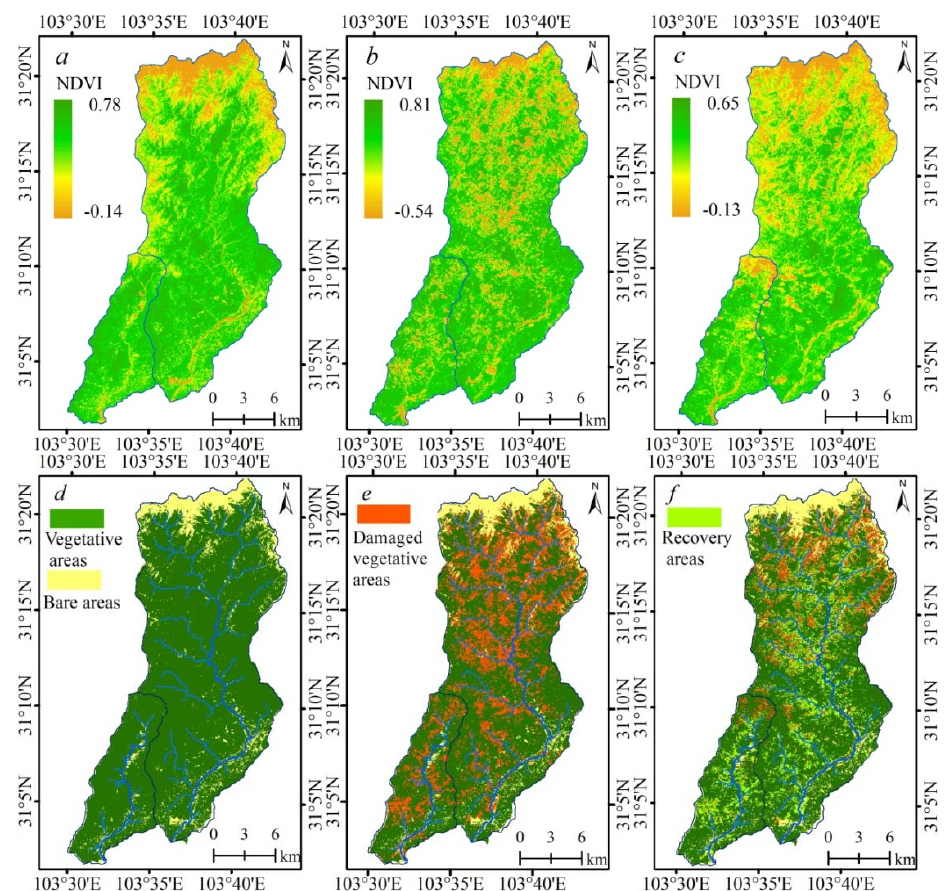
Figure 4. Multi-temporal NDVI images and vegetation changes processes at the study area: ( a ) Pre-earthquake NDVI image; ( b ) 2008–2009 NDVI image; ( c ) 2014 NDVI image; ( d ) pre-earthquake vegetation distribution map; ( e ) earthquake-damaged vegetation distribution map; ( f ) vegetation recovery conditions